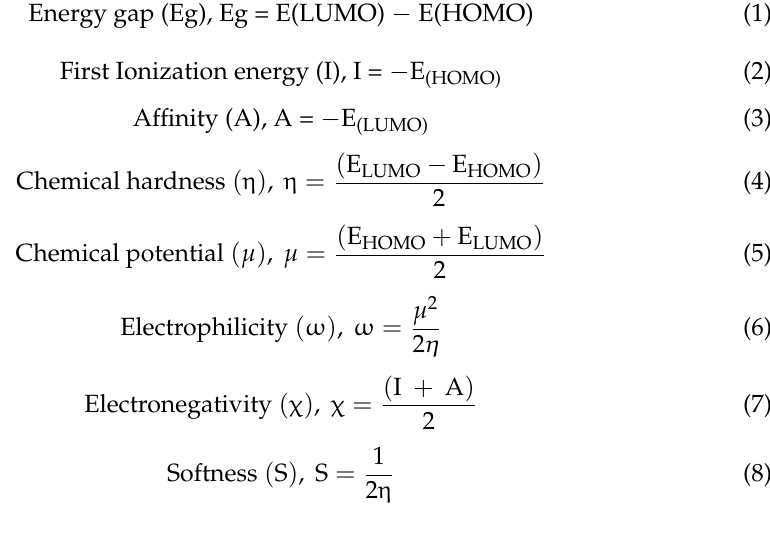
Figure 12. Absolute error between calculated energy gap (Eg) using different functionals and experimental value (3.6